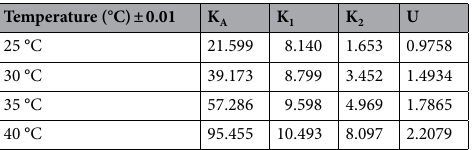
Table 4. Calculated values of K 2 and U for Sodium N , N -Dimethyl dithiocarbamate in Dimethylformamide at 25, 30, 35 and 40°Cand 1 atm.